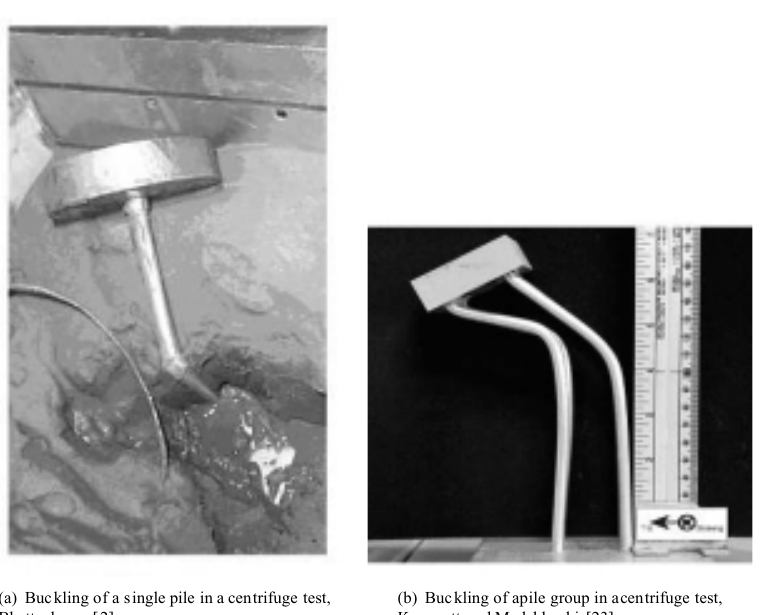
Fig. 2. Buckling pattern of single pile and a pile group in a centrifuge